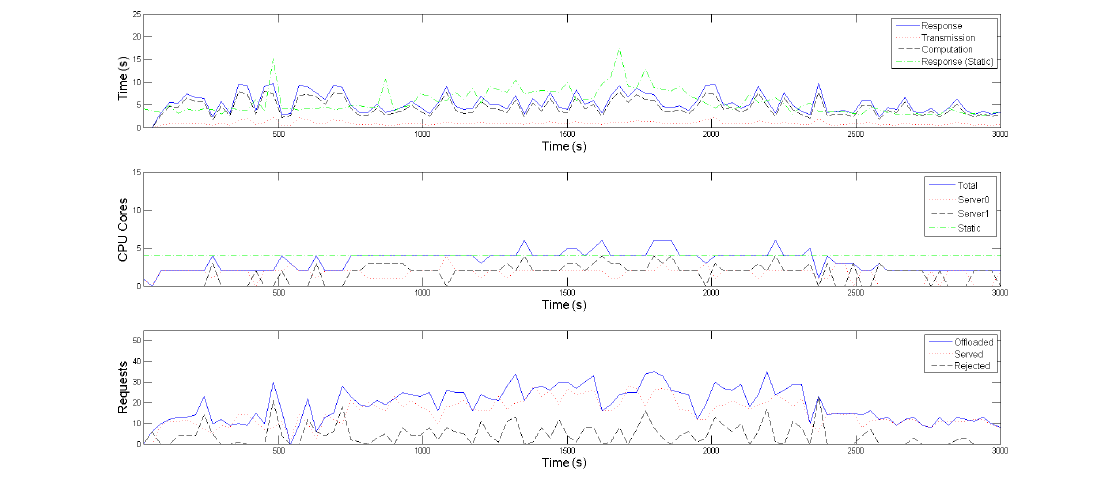
Figure 5. Conventional Tensorflow